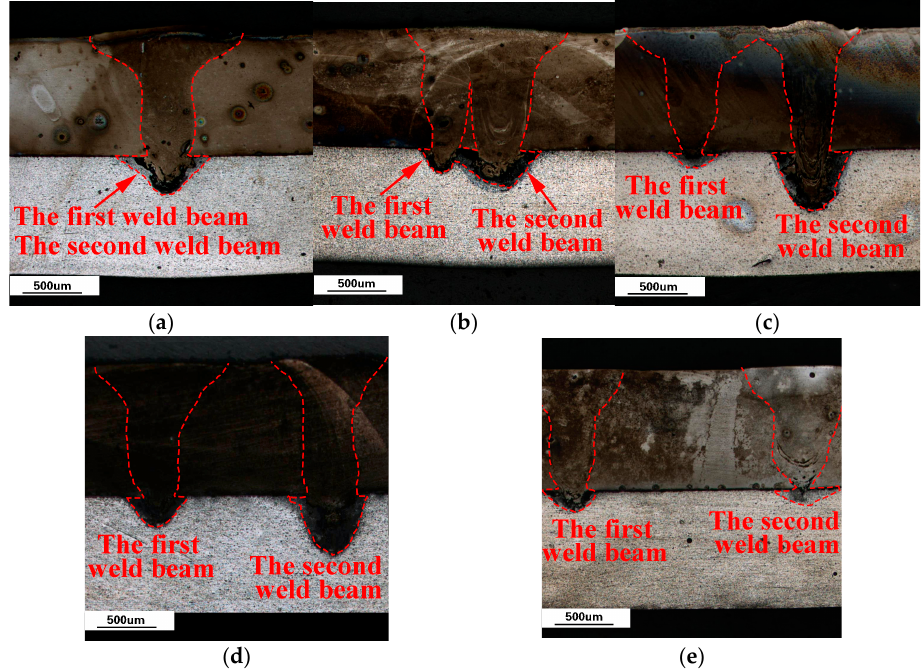
Figure 4. The cross-sectional appearance of the weldment with di ff erent weld spacing. ( a ) 0 mm weld spacing; ( b ) 0.5 mm weld spacing; ( c ) 1.0 mm weld spacing; ( d ) 1.5 mm weld spacing; ( e ) 2.0 mm weld spacing.